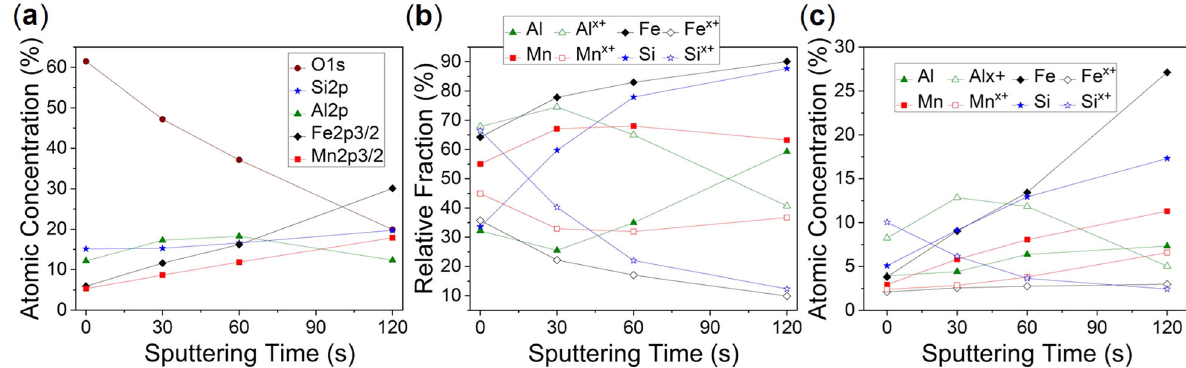
Fig. 5 XPS of the AlFeMnSi surface after potentiostatic conditioning for 1 h at − 700 mV SCE in 0.6 M NaCl. Distribution of elements as a function of sputtering time determined by XPS following potentiostatic conditioning for 1 h at − 700 mV SCE of the AlFeMnSi alloy in 0.6 M NaCl: a atomic concentration, b relative fraction of oxidized element to corresponding unoxidized metal species, and c atomic concentration of oxidized and unoxidized